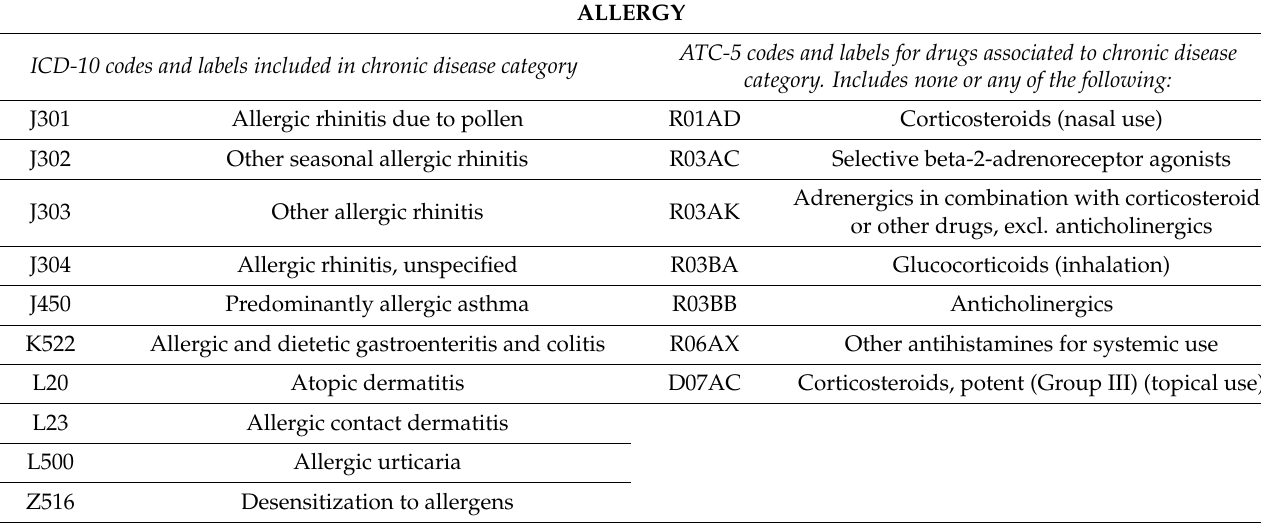
Table A3. Mapping of SNAC-K chronic disease categories and their associated ATC drugs categories (first two categories). ALLERGY ATC-5 codes and labels for drugs associated to chronic disease ICD-10 codes and labels included in chronic disease category category. Includes none or any of the